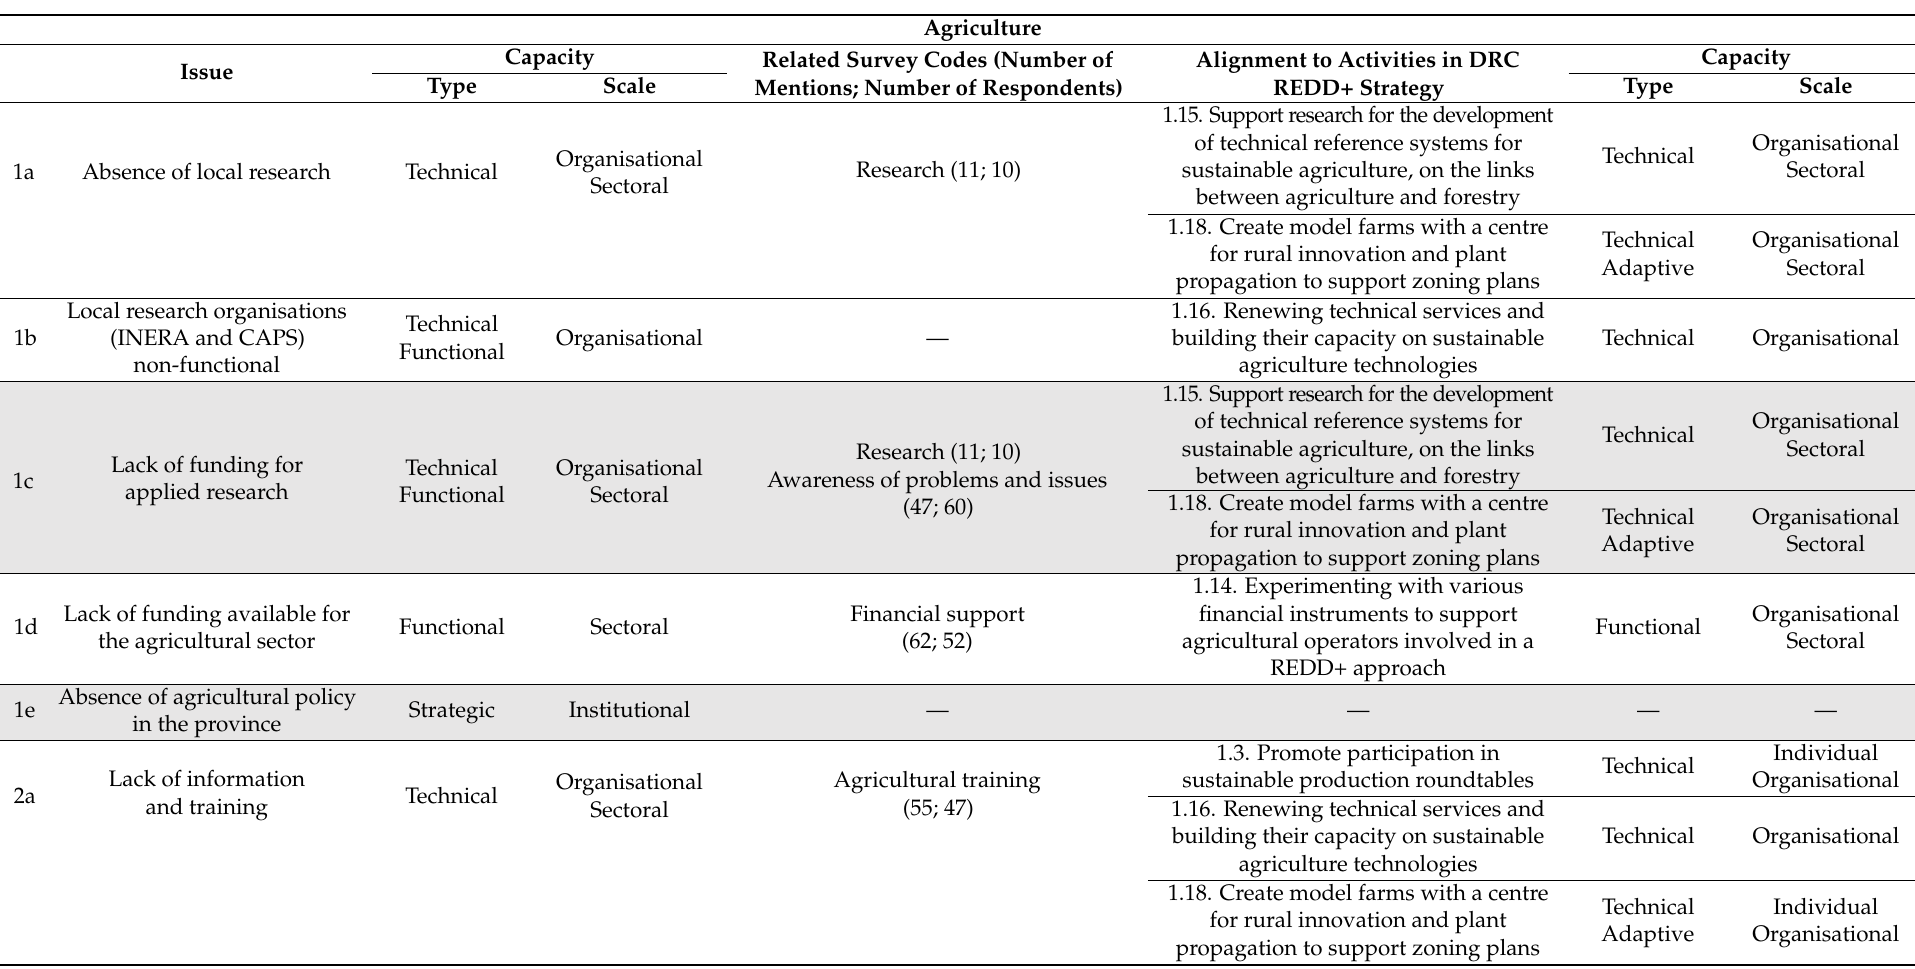
Table 1. Agricultural Sector Capacity Issues Identified in É quateur Provincial Government Stakeholder Workshop and Aligned DRC REDD+ Strategy Actions. Highlighted issues in grey are proximal issues from the bottom of problem tree